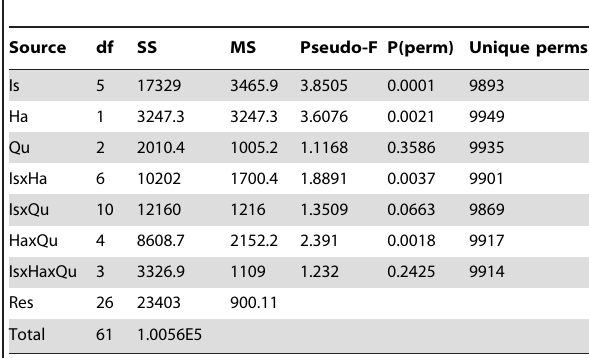
Table 1. Results of PERMANOVA main test.